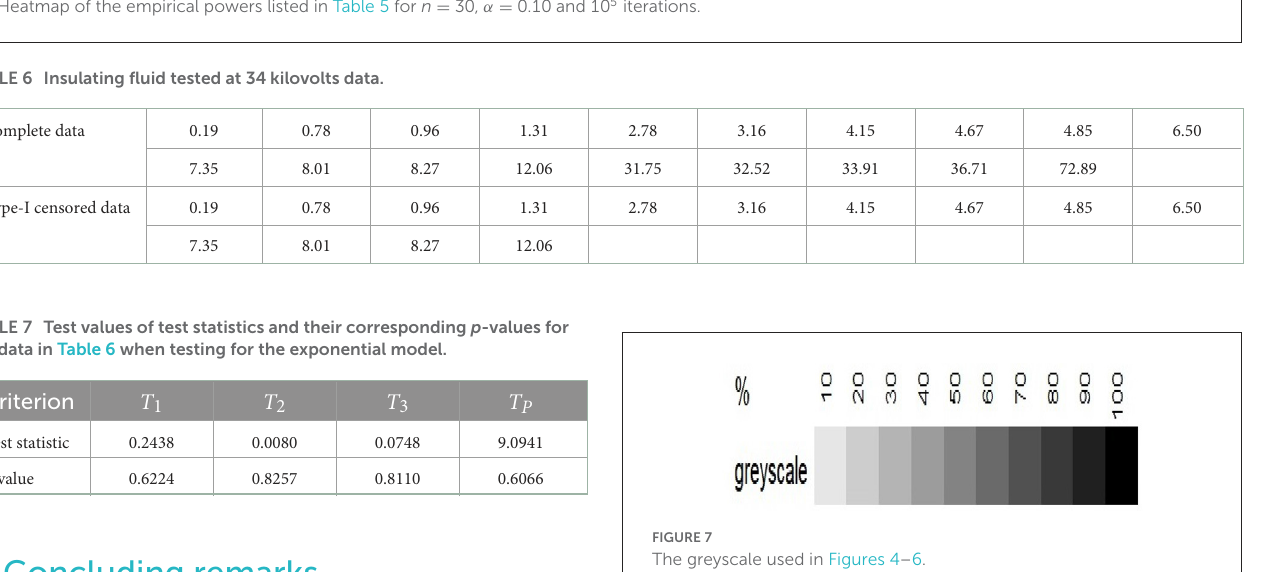
30, α 0.10 and 10 5 iterations. = =